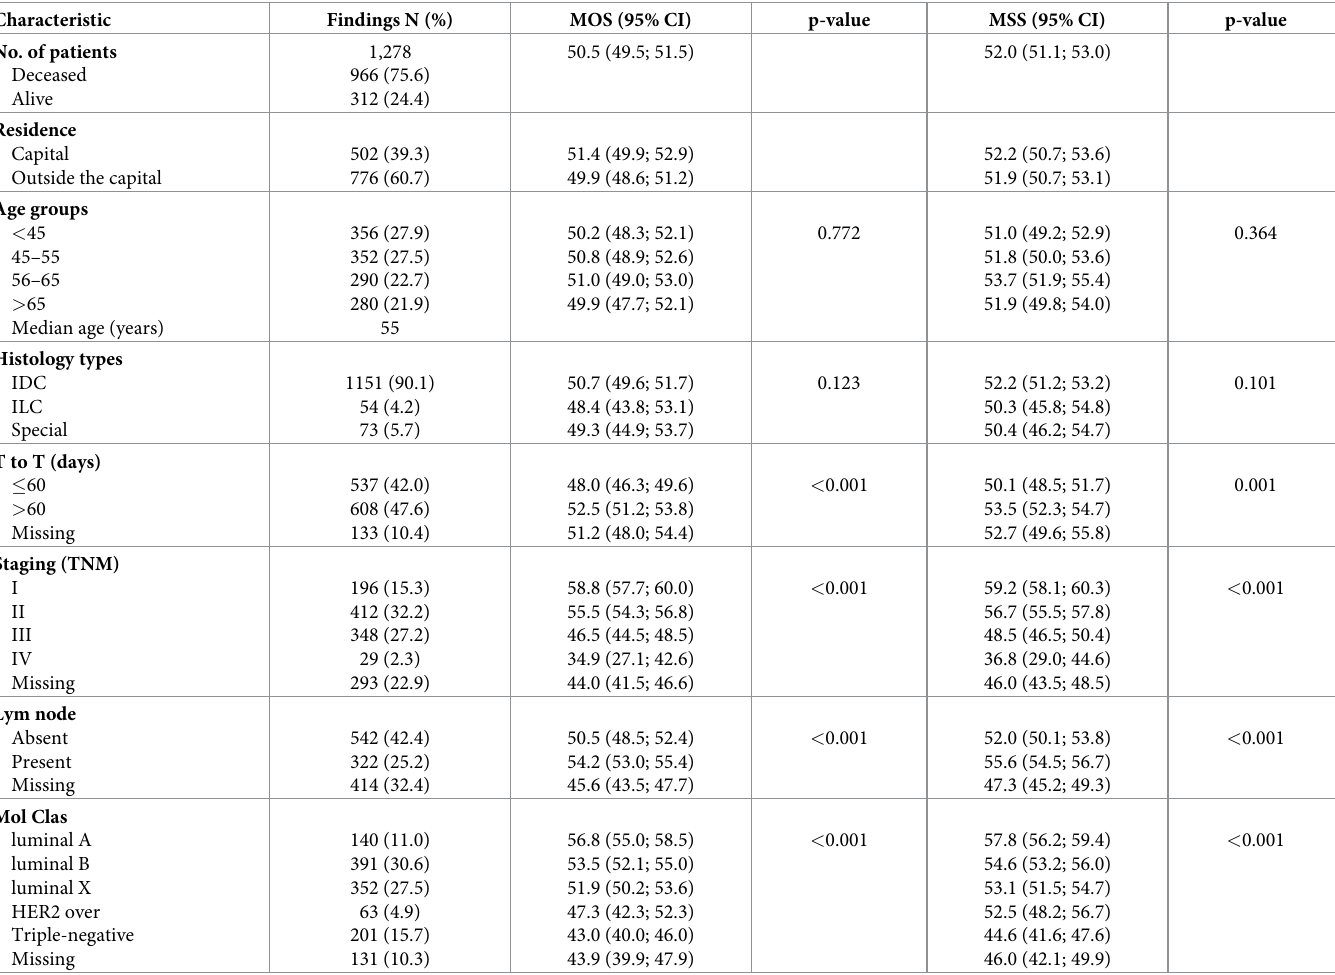
Table 1. Descriptive statistics and mean overall and cancer-specific survival of the cohort during the